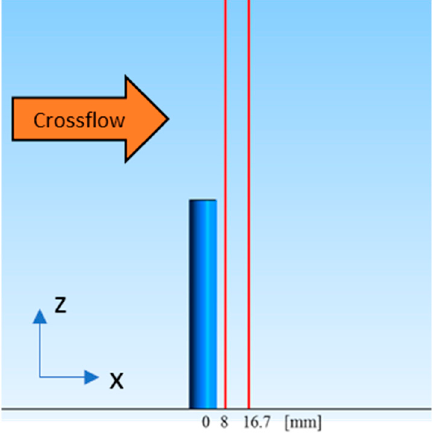
Figure 3. Control stations—axial coordinate from origin (duct centerline).